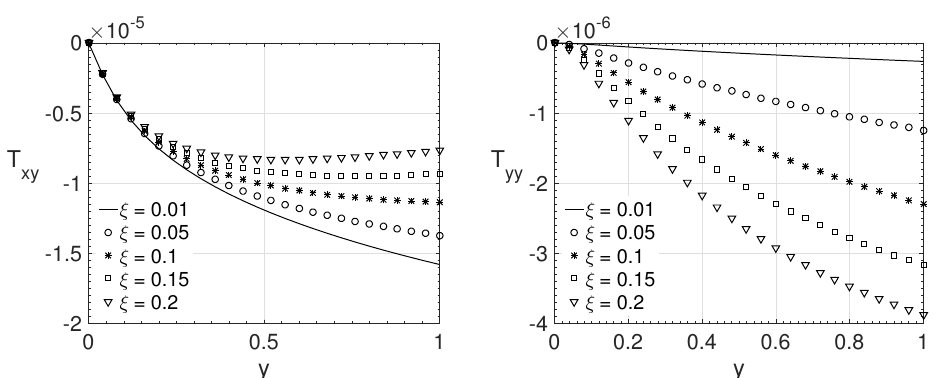
Figure 9. ξ influence on the wall-normal variation y of the streamwise velocity component u and the extra-stress tensor components T xx , T xy and T yy . Dimensionless parameters: Re = 10,000, β = 0.5, (cid:101) = 1 and Wi = 5.